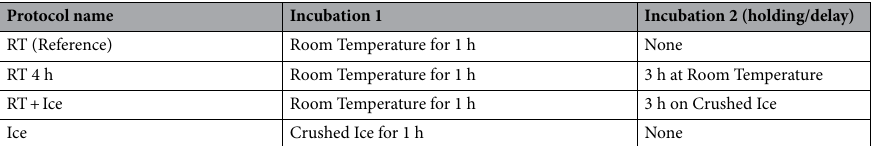
Table 1. Handling protocols. Blood samples (serum and plasma) were subjected to Incubation 1 only (Reference and Ice protocols) or subjected to Incubation 1 followed immediately by Incubation 2 (RT 4 h and RT + Ice protocols) prior to processing and storage at −80